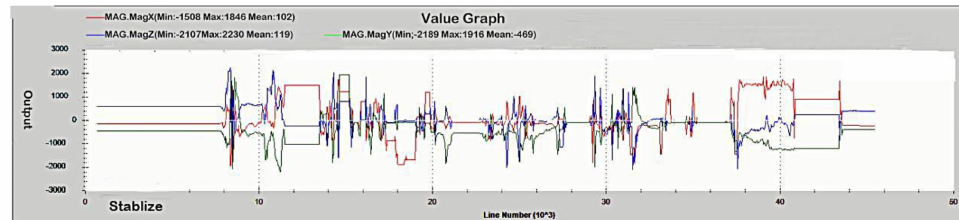
Figure 5. The curve of course angle of UAV under test condition 1. The curve in the graph is the sampling point curve, where the unit of the vertical axis is degree. The green line is the expected value of the heading angle, and the red line is the heading angle calculated by the magnetometer. The amplitude of the course is 0.8 degrees.